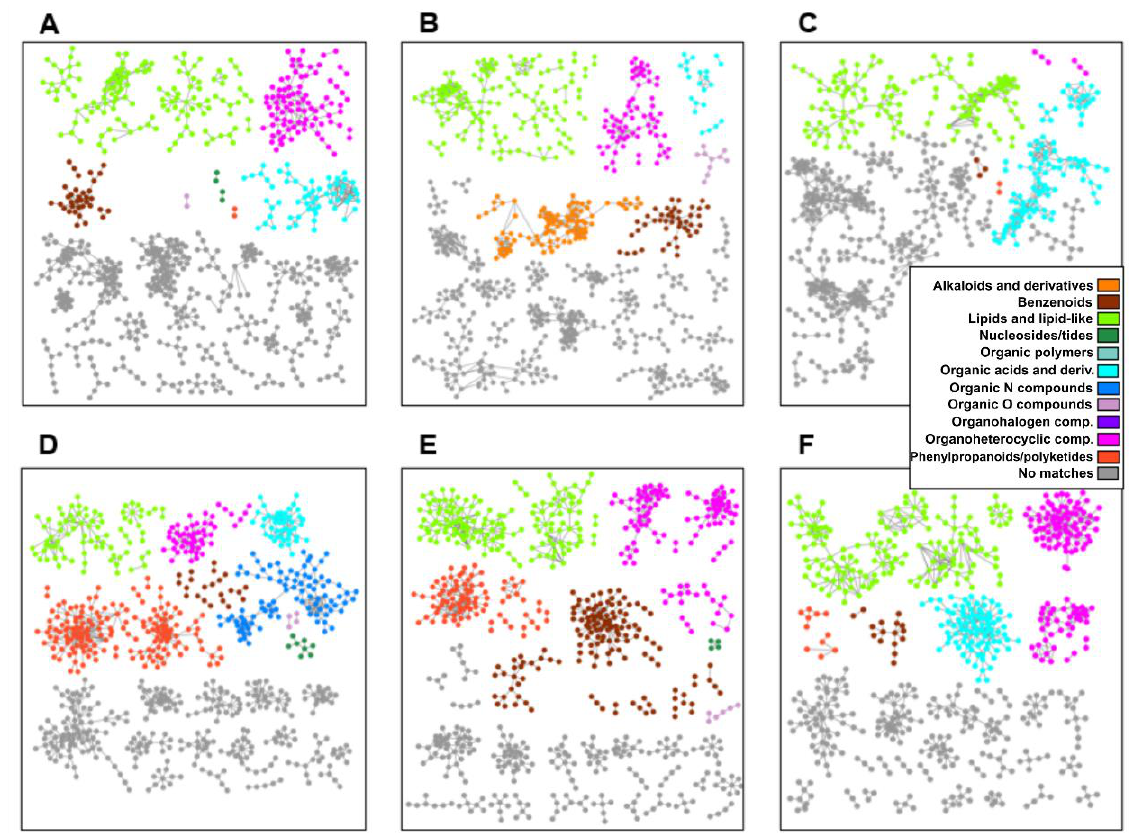
Figure 4. Classical GNPS molecular networks of Avatar ( A , D ), Desiree ( B , E ), and Seresta ( C , F ) root exudate LC-ESI-QTOF-MS data, analyzed in positive ( A – C ) and negative modes ( D – F ). Networks were constructed using default settings. Nonconnected nodes and gray networks consisting of 4 or fewer nodes were deleted to improve visibility.